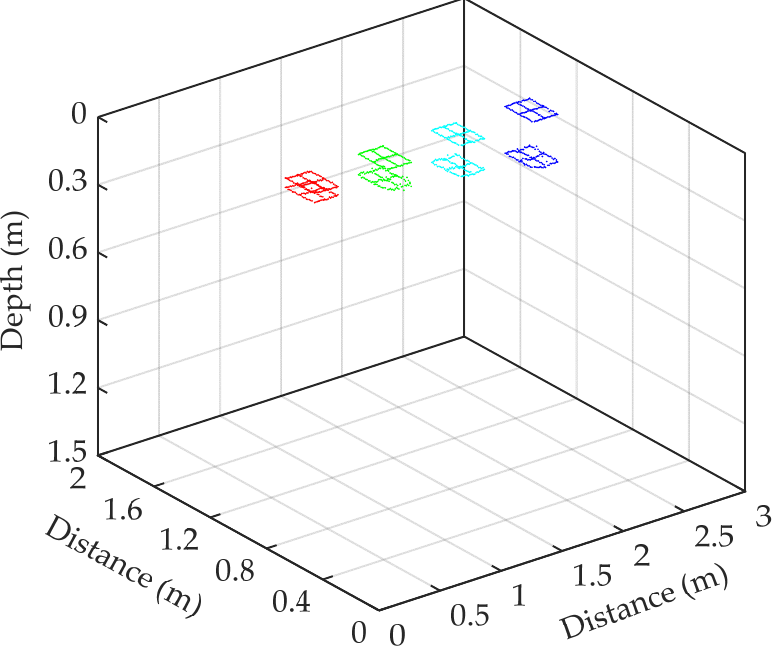
Figure 19. Three-dimensional scatter diagrams formed from the characteristic values of void fill- ers.